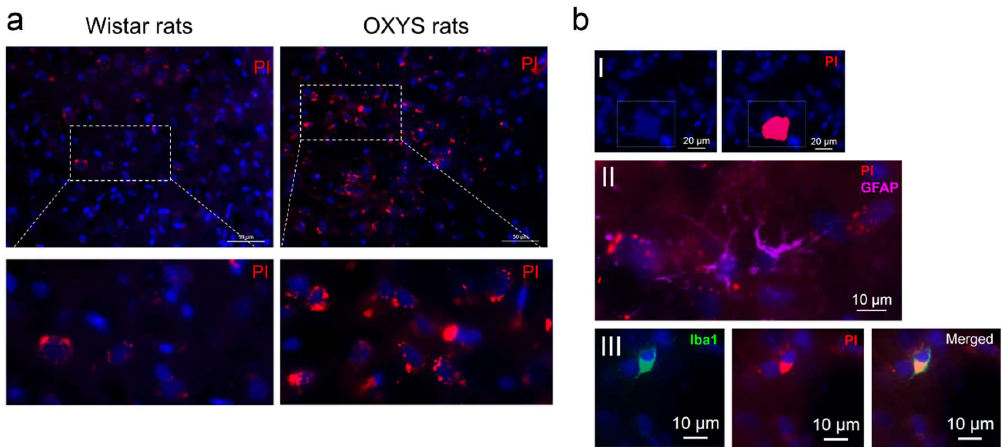
Figure 5. Examples of propidium iodide (PI) fluorescence in the cortex after in vivo administration to